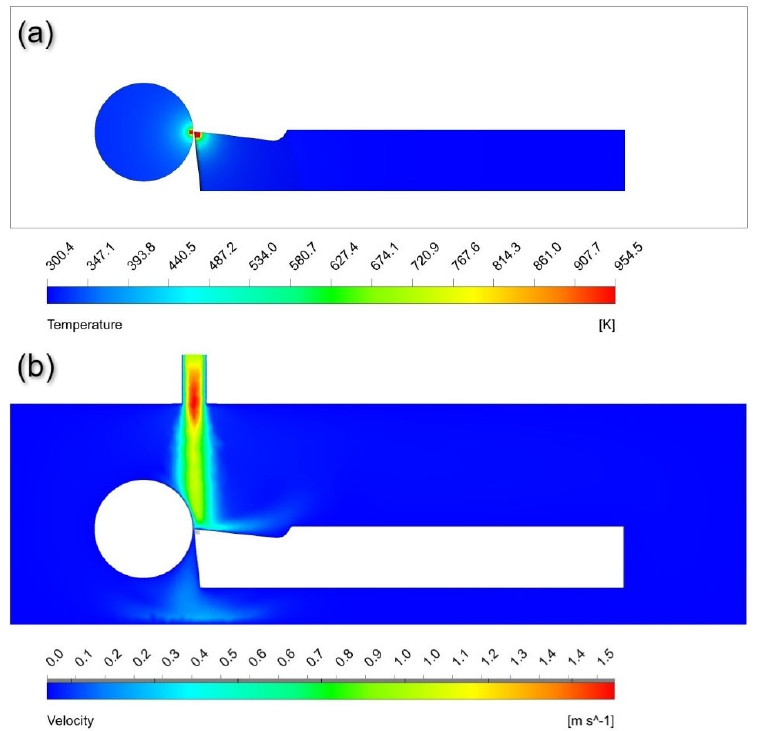
Figure 8. ( a ) Temperature distribution on the cutting tool and workpiece at steady state. ( b ) Velocity contours in the computational domain representing the flow of nanofluid on the machining interface.